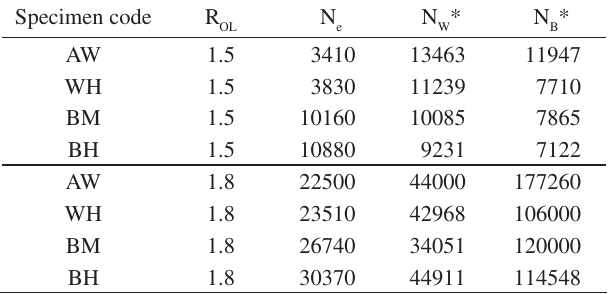
Table 8. Delay cycles numbers calculated using the Wheeler and Willenborg models. Specimen